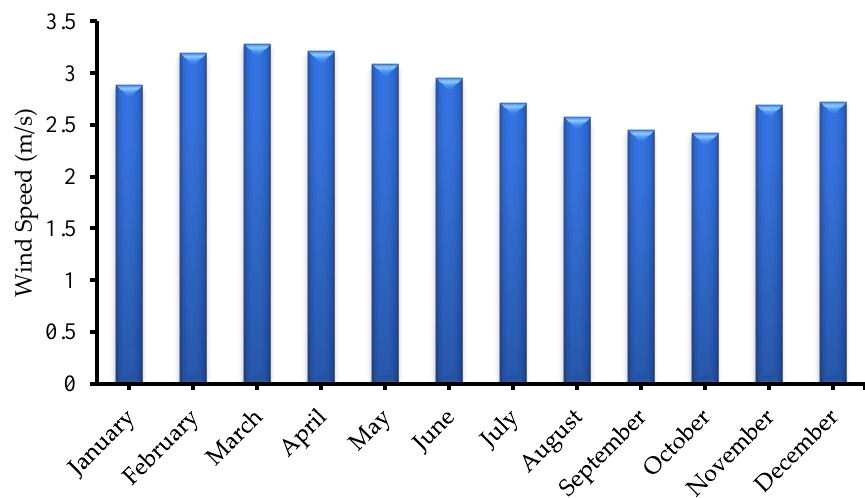
Figure 4. Information on the monthly mean wind speed.